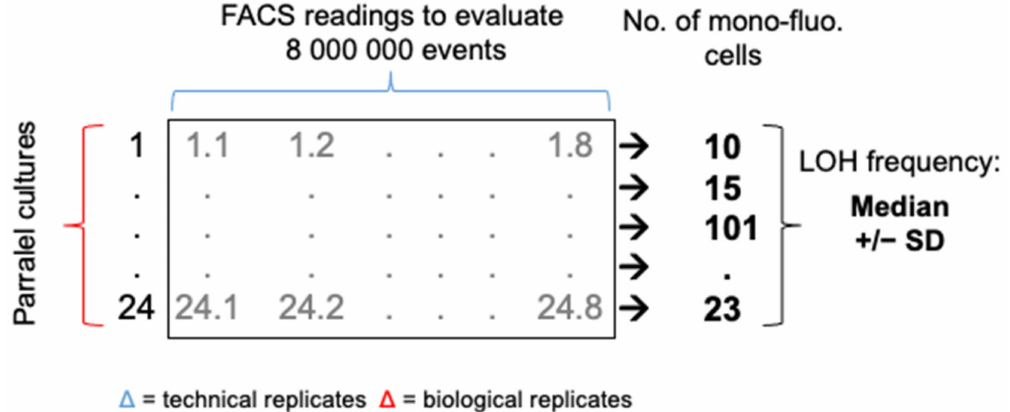
Figure 1. Schematic representation of the fluctuation analysis to determine an accurate LOH frequency. For a given strain in one growth condition, 24 parallel cultures are generated. For each parallel culture, 8 FACS analyses of 10 6 cells are conducted for a total sampling size of 8 × 10 6 cells. A total number of mono-fluorescent cells is calculated per parallel culture. The median LOH frequency (+/ − SD) is assessed using the 24 parallel